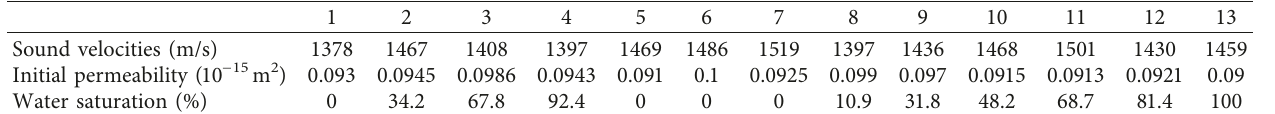
Table 2: Initial information of coal rock samples.